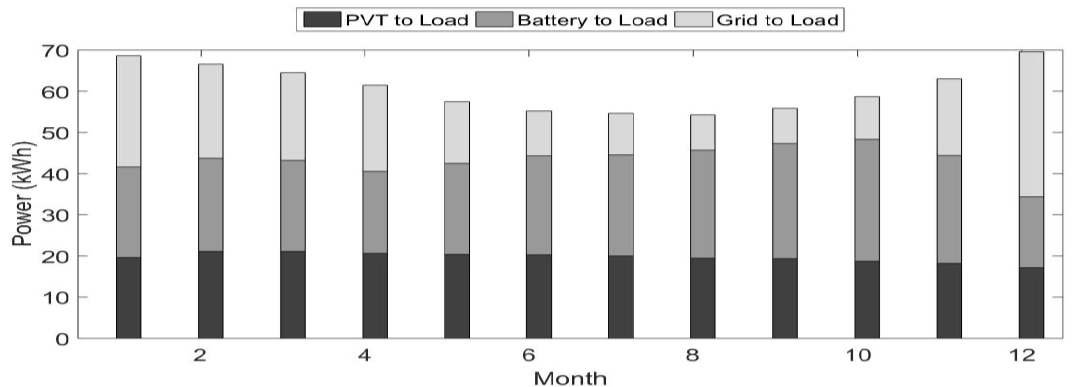
Figure 7. Monthly totals for the year in terms of three categories of power used to meet the load.